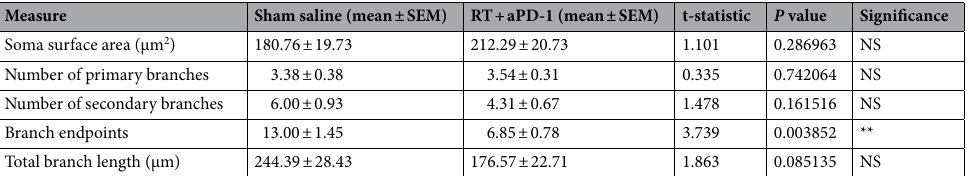
Table 1. Summary of microglia characteristics in RT + aPD-1 treated mice and controls. The first column lists the measures of characteristics evaluated and the measurement units in parenthesis, when applicable. The second the third columns list the mean ± SEM for each measurement from the control group (sham saline) and RT + aPD-1 treated mice, respectively. The fourth column lists the t statistic for each measurement. The last column indicates the corresponding P value for Student’s t test. Microglia from RT + aPD-1 treated mice had fewer branch endpoints compared to the controls. Microglia characteristics were similar with regards to soma surface area, number of primary branches, number of secondary branches, and total branch length between the two groups. ** P <